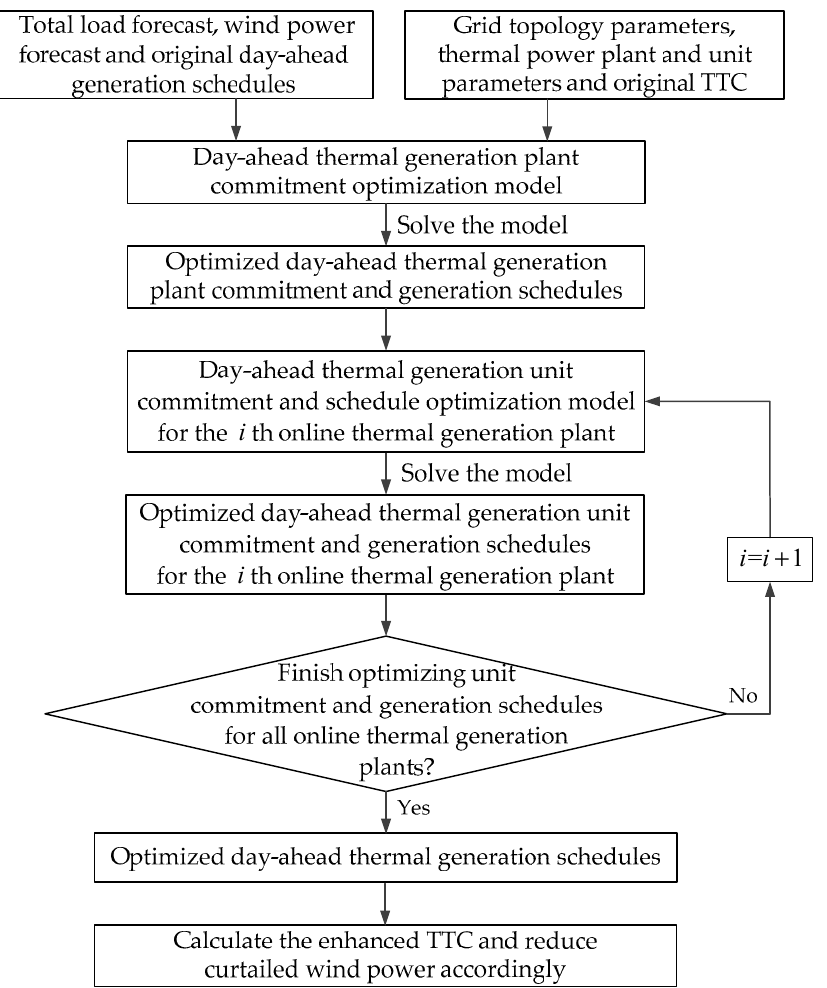
Figure 7. Flow diagram of the optimal day-ahead thermal generation scheduling method.